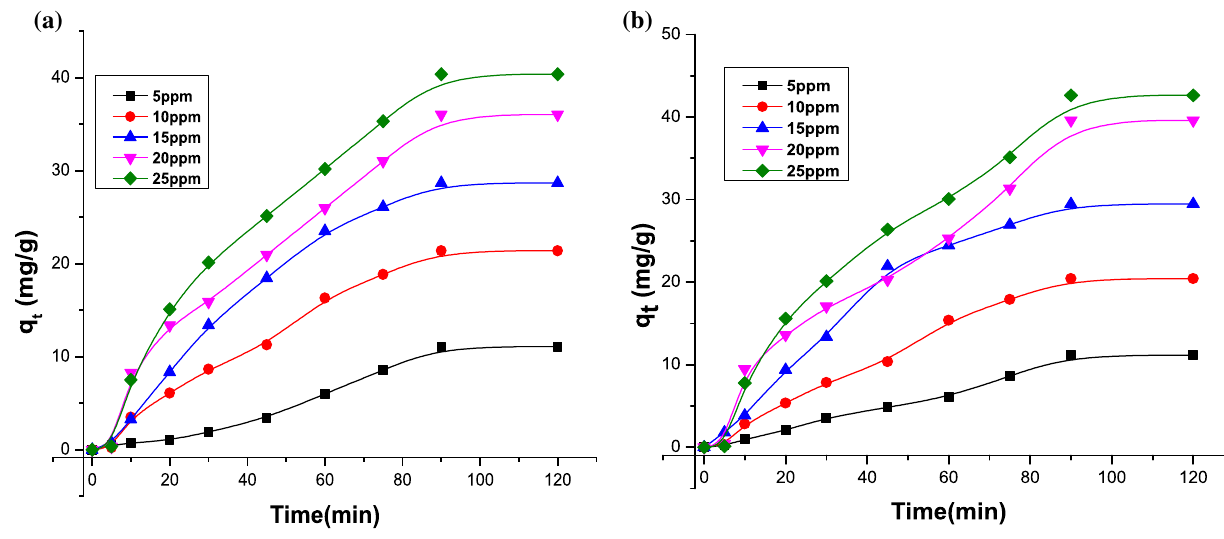
Fig. 7 Effect of contact time and initial concentration on the adsorption of deltamethrin onto a KOHAWS1 and b